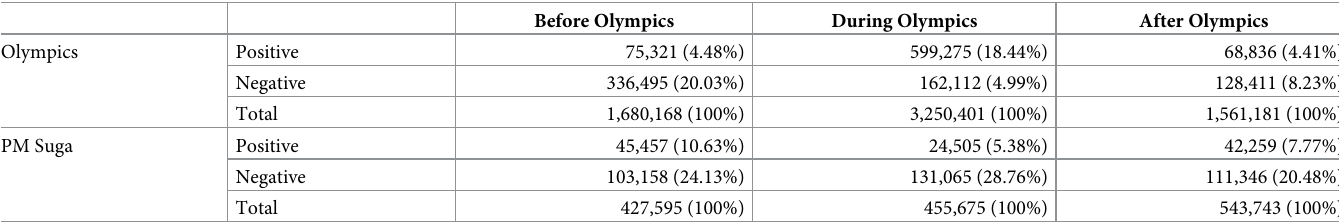
Table 2. Number of users (including